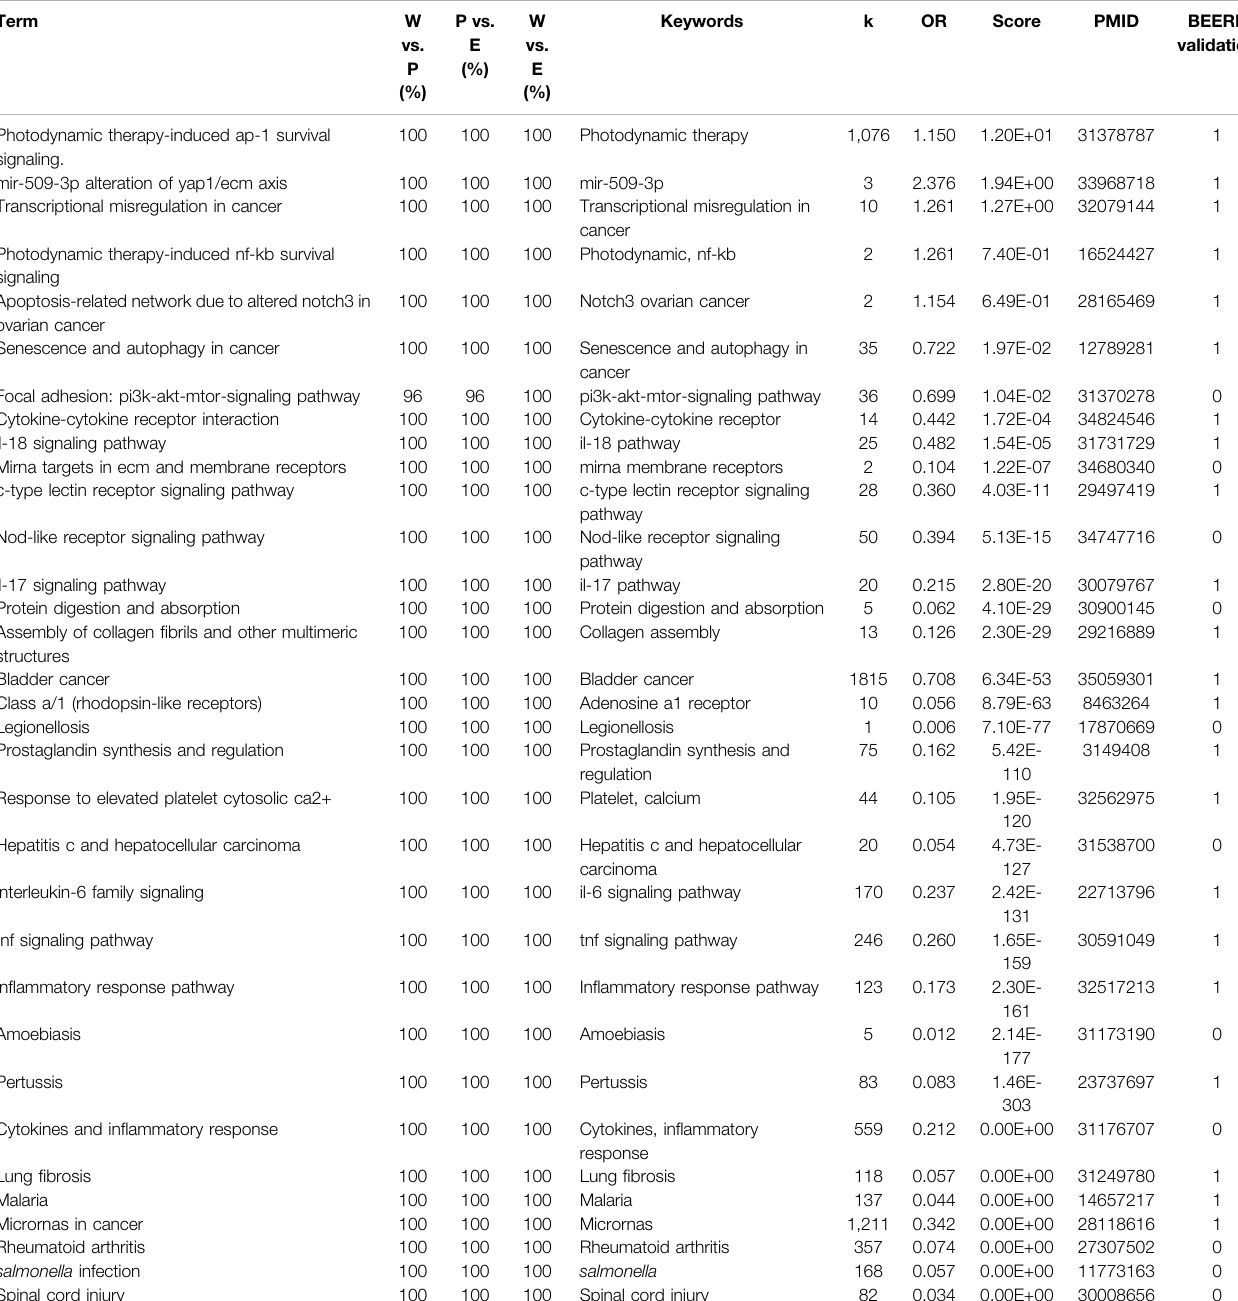
TABLE2| The33consensuspathwaysamongPAGER,EnrichR,andWebGestaltRresultswithPubMedliteraturesupport.Wvs.Prepresentsthetermsimilaritiesbetween WebGestaltR and PAGER results. P vs. E represents the term similarities between PAGER and EnrichR results. W vs. E represents the term similarities between WebGestaltR and EnrichR. k represents the citations of “ melanoma ” and the keywords from a pathway. OR represents the odds ratio. Score represents the PubMed score . PMID represents one PubMed ID example from each entry. BEERE validation represents the semantic relationships retrieved. 1 stands for Yes, and 0 stands for No. All these abbreviations are applied to Table 3 and Table 4